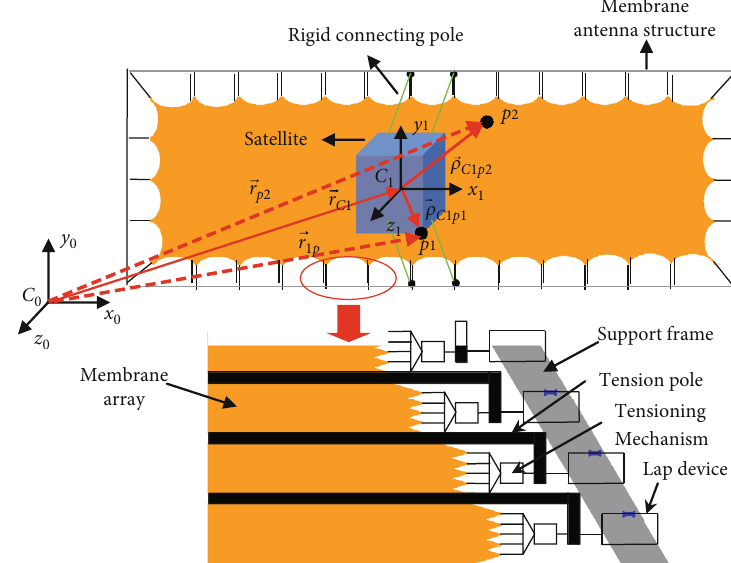
Figure 1: Satellite with membrane antenna structure.